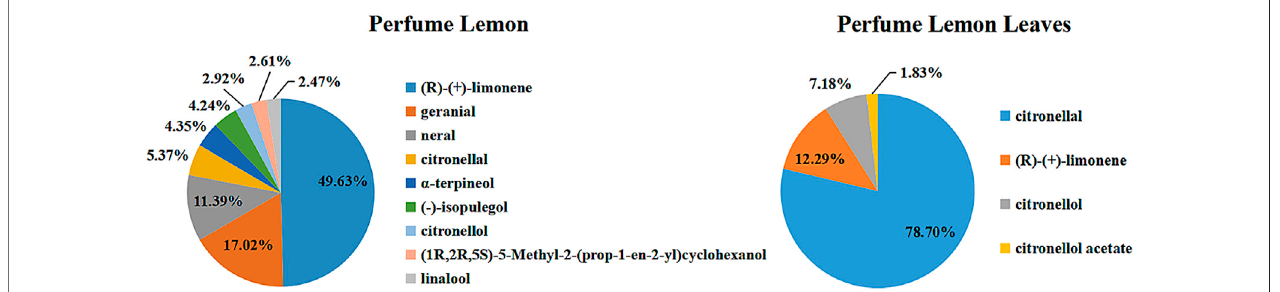
FIGURE 2 | Chemical compositions of the two essential